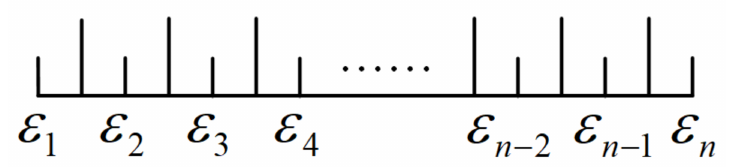
Figure 3. Partition of the